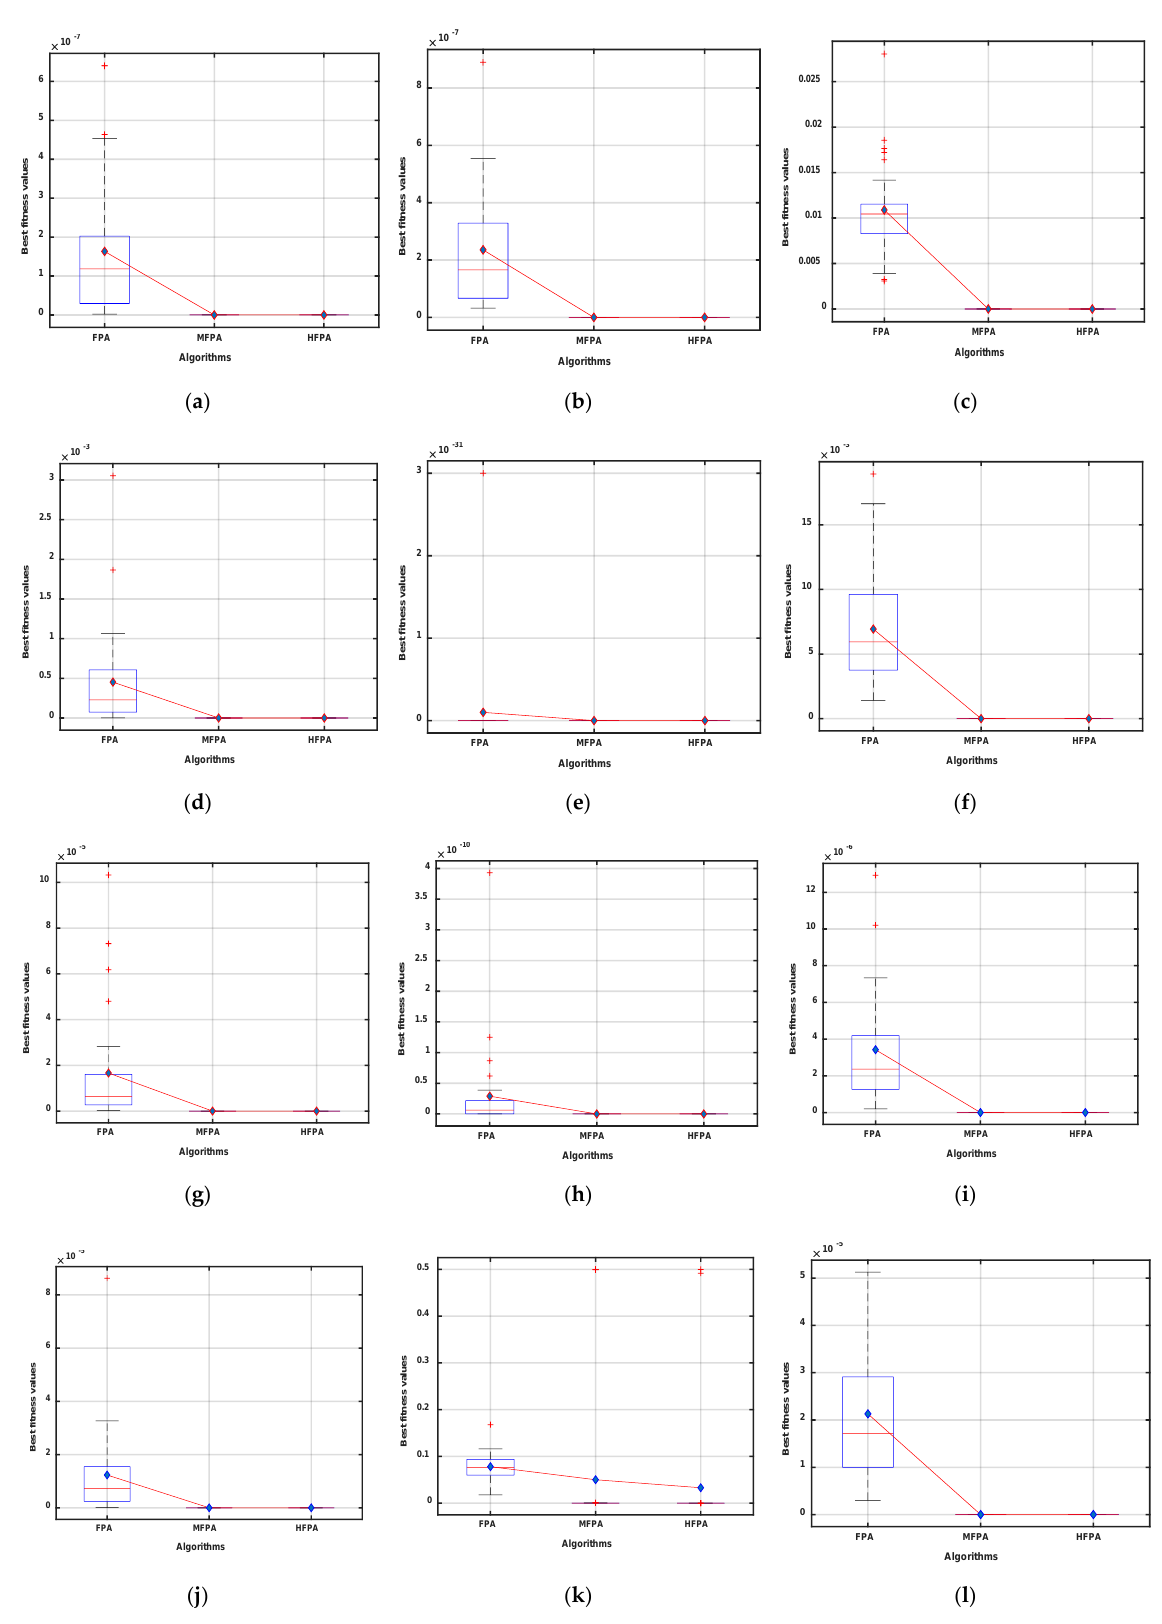
Figure 12. Comparison among FPA variants under Boxplot: ( a ) Boxplot for f1; ( b ) Boxplot for f2; ( c ) Boxplot for f3; ( d ) Boxplot for f5; ( e ) Boxplot for f6; ( f ) Boxplot for f7; ( g ) Boxplot for f8; ( h ) Boxplot for f9; ( i ) Boxplot for f10; ( j ) Boxplot for f11; ( k ) Boxplot for f12; ( l ) Boxplot for f13.